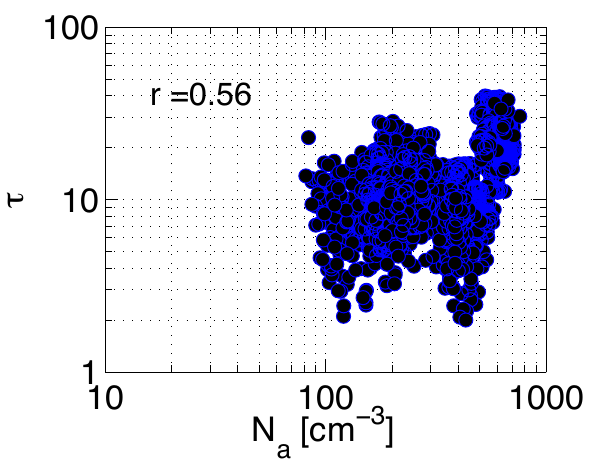
and τ . 1022 Fig. 8. Scatterplot between N a